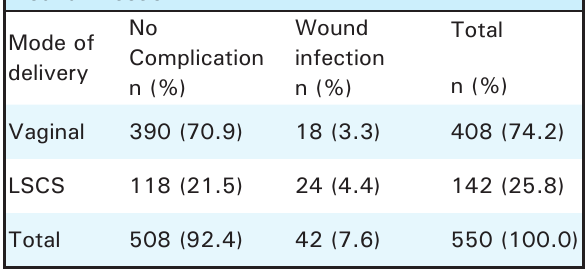
Table 4. Association between mode of delivery and wound infection.